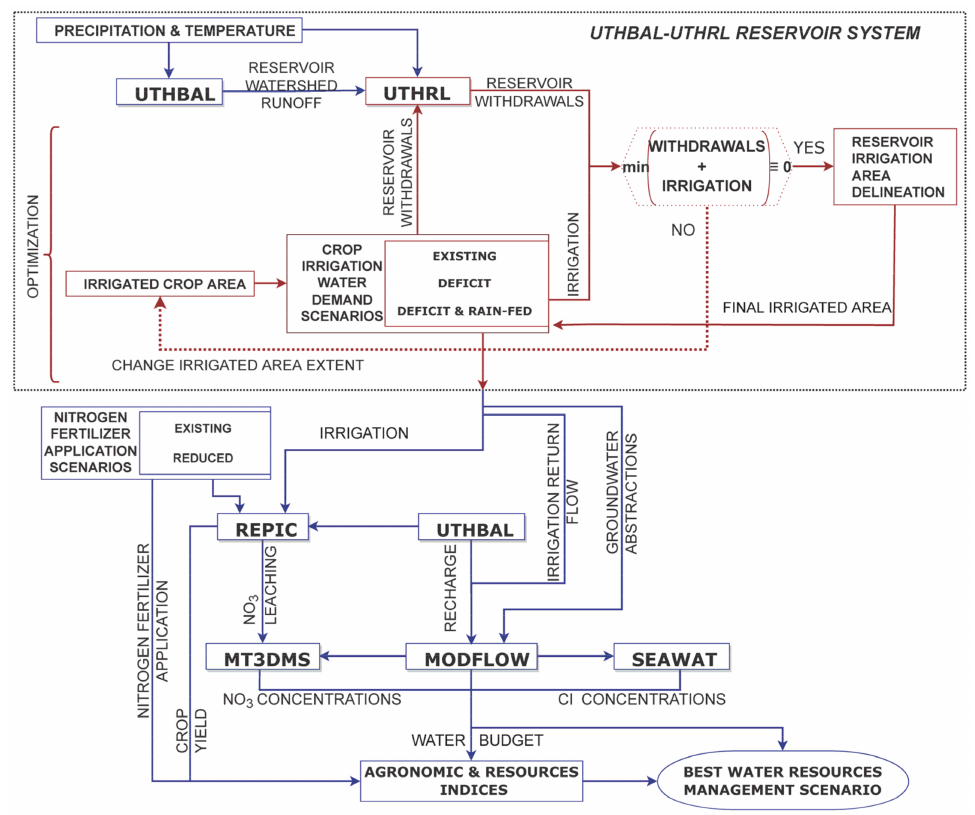
Figure 4. Flowchart of the Modeling System and the Reservoir Simulation-Optimization